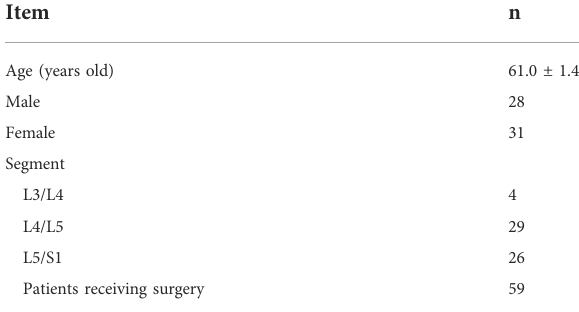
TABLE 1 Basic data of